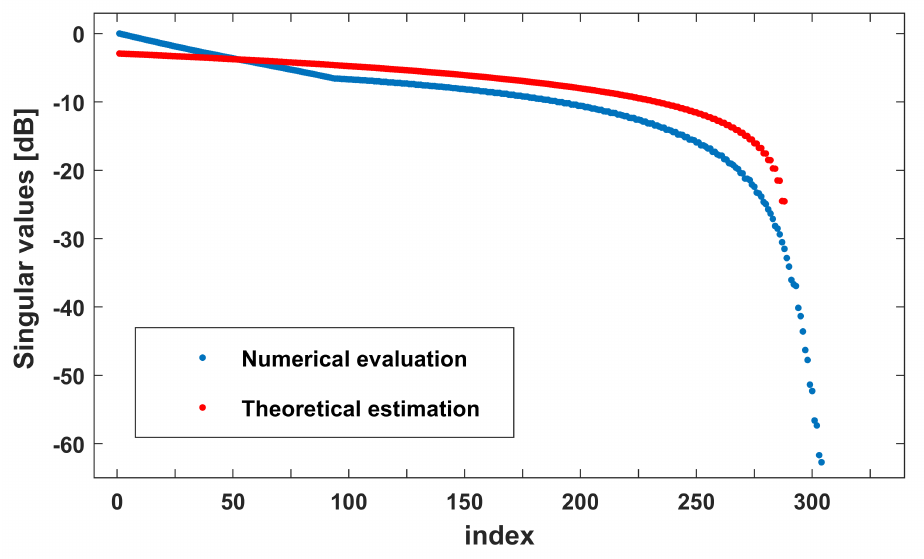
Figure 9. Singular values of A numerically computed, and their analytical estimation for the case a = 20 λ , z 1 = 5 λ , z 2 = 5.67 λ , X 1 = 20.75 λ ( η ( X 1 , z 1 ) = 0.9 ) , X 2 = 21.47 λ ( η ( X 2 , z 2 ) = 0.9 ) . A third test case concerns the configuration z 1 = 5 λ , z 2 = 7.5 λ , X 1 = 20.75 λ ( η ( X 1 , z 1 ) = 0.9), X 2 = 23.75 λ ( η ( X 1 , z 1 ) = 0.9). Hence, the distance | z 2 − z 1 | has